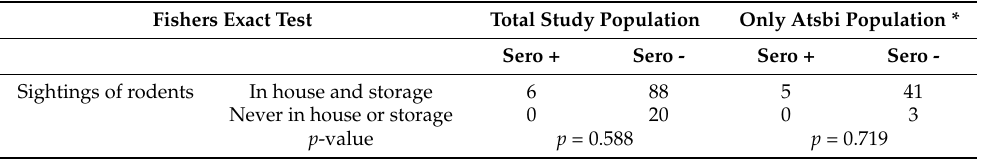
Figure 3. Illustration of stone bund identification in a high resolution (4 cm) orthophotograph of the study area in Hagere Selam. ( A ) Section of the orthophotograph showing the boundaries between the village and the surrounding arable fields including stone bunds. ( B ) Digital elevation model (DEM) with a spatial resolution of 3 cm and altitude of objects ranging between 2438 and 2489 m. ( C ) Stone bund (red lines) digitized in and outside the village. ( A – C ) show the same section of the study area. ( D ) Stone bunds digitized for the whole study area in Hagere Selam. The shaded area represents the village, and the black lines delineated the 100 m buffer area within which stone bunds outside the village were digitized. The width of the big-sized stone bunds is >40 cm, that of medium-sized ones is 20–40 cm and small-sized stone bunds have a width <20 cm and generally have only one or two layers of stones. Table 7. Output from Fisher’s exact test of the association between the variables Sightings of rodents and Serostatus, both for the total study population and only for Atsbi